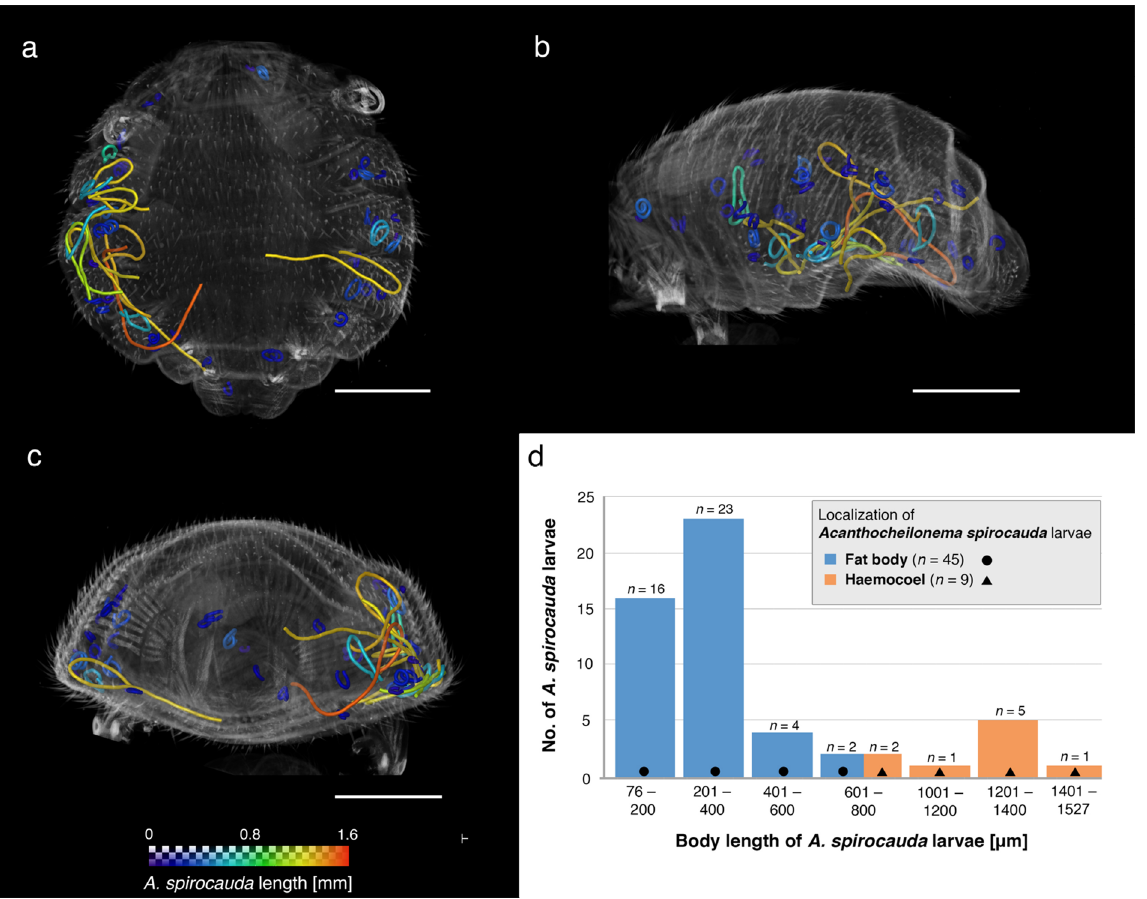
Figure 3. 3D reconstruction of Echinophthirius horridus based on X-ray microCT showing Acanthocheilonema spirocauda larvae ordered by body length. ( a ) Ventral view. ( b ) Lateral view. ( c ) Caudal view. ( d ) Overview of larval localization in relation to body length. Scale bars: 500 µm.